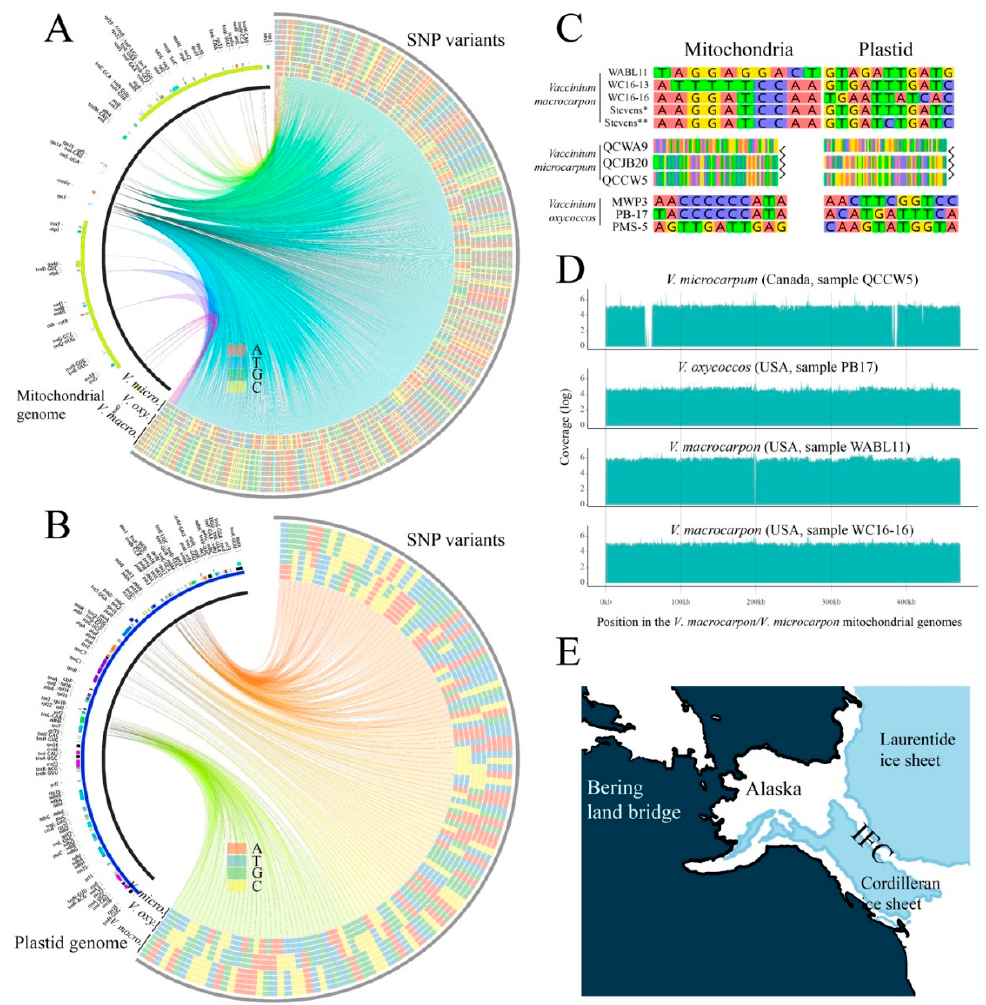
Figure 4. SNP variants among V. macrocarpon , V. microcarpum , and V. oxycoccos . SNP (single nucleotide polymorphism) variants detected in mitochondria ( A ) and plastid ( B ) genomes among all 11 samples sequenced with both Illumina and PacBio. On the heatmaps (right arcs), the inner three rings correspond to the V. microcarpum samples QCCW5, QCJB20, and QCWA9; the next three rings (4–6) correspond to the V. oxycoccos samples MWPB3, PB17, and PMS5; rings 7–9 correspond to the wild V. macrocarpon samples WABL11, WC16-13, and WC16-16; and rings 10–11 correspond to cultivated V. macrocarpon sequenced with Illumina and PacBio, respectively (note these last two sequences were identical to the Alaskan V. microcarpum sequences). Each SNP is connected by a colored link to its physical position within either the mitochondria or plastid genome (left to right arcs); link colors are meaningless. For reference purposes, gene locations were added on the left arcs and colored by category. ( C ) SNP variants were called when aligning sequences by species; for the V. macrocarpon alignment, Stevens* correspond to the assembly carried out with Illumina data (used to validate the PacBio assembly), whereas Stevens** correspond to the one with PacBio; for V. microcarpum , only the first positions of the alignment are shown. ( D ) Coverage plots using Illumina filtered raw reads and V. macrocarpon / V. microcarpum mitochondrial genomes as reference (additional coverage plots are provided in Figures S1 and S2). ( E ) Ice extent between 9–10 k years ago showing the ice-free corridor (IFC). 3.5. Relationships among Diploids, and the Link between Alaskan V. microcarpum and V. macrocarpon Vaccinium macrocarpon and V. microcarpum displayed dramatically different genetic diversity. Our samples of V. macrocarpon span 1700 km from Wisconsin to the east coast. Despite the geographic distance, four samples yielded only 21 intraspecific SNPs combined for the chloroplast and mitochondrial genomes. In contrast, we found 564 intraspecifc SNPs in three V. microcarpum samples